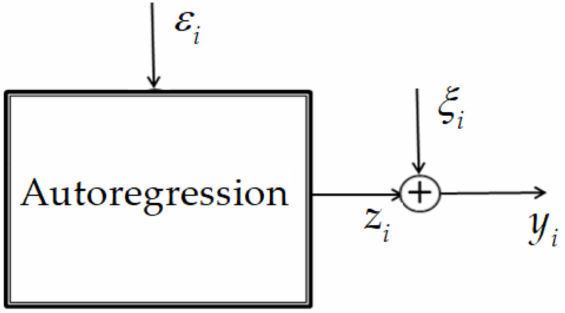
Figure 1. Autoregressive model in presence of an additive